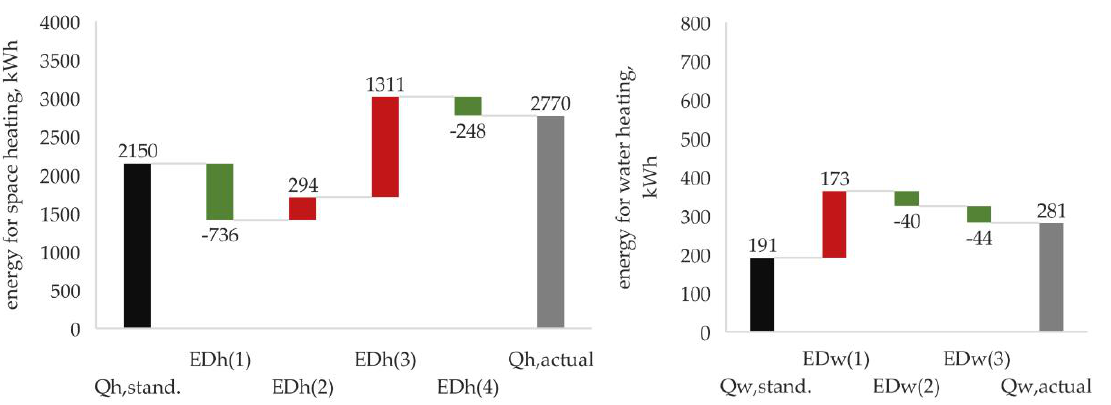
Figure 5. Influence of individual parameters on the values of energy consumption for heating ( Q h ) and hot water preparation ( Q w ) for unit A.